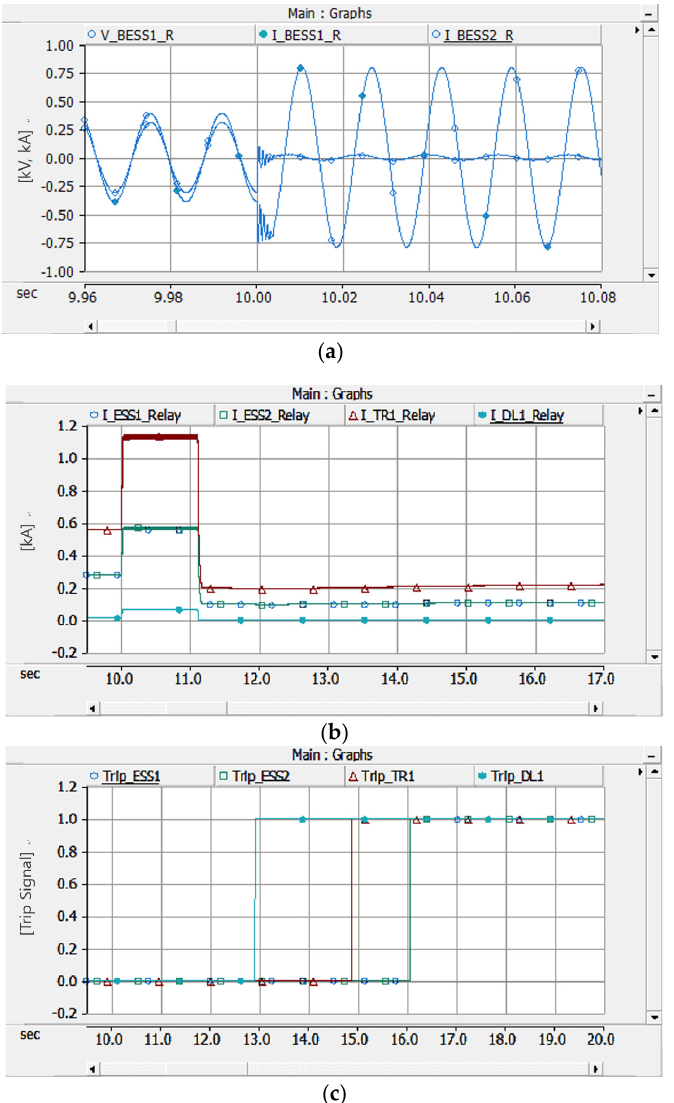
Figure 11. Simulation results of Case #2: ( a ) voltage and current of ESS#1 and #2; ( b ) current of each relay; ( c ) trip signal of each relay.